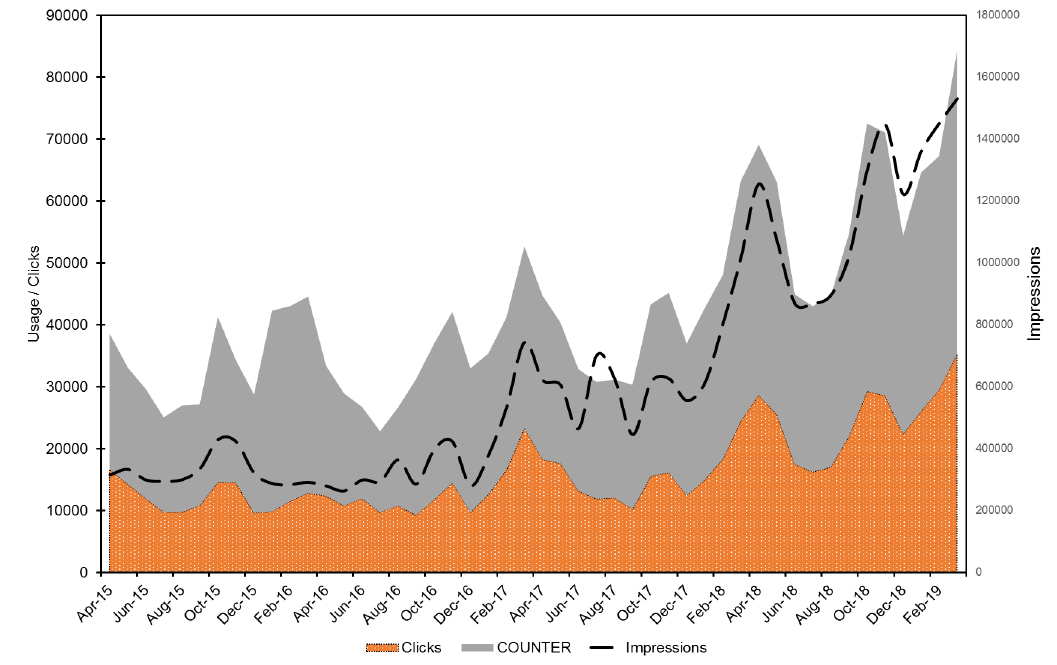
Figure 3. Strathprints COUNTER usage during Y1–Y4 alongside Google clicks and impressions during the same